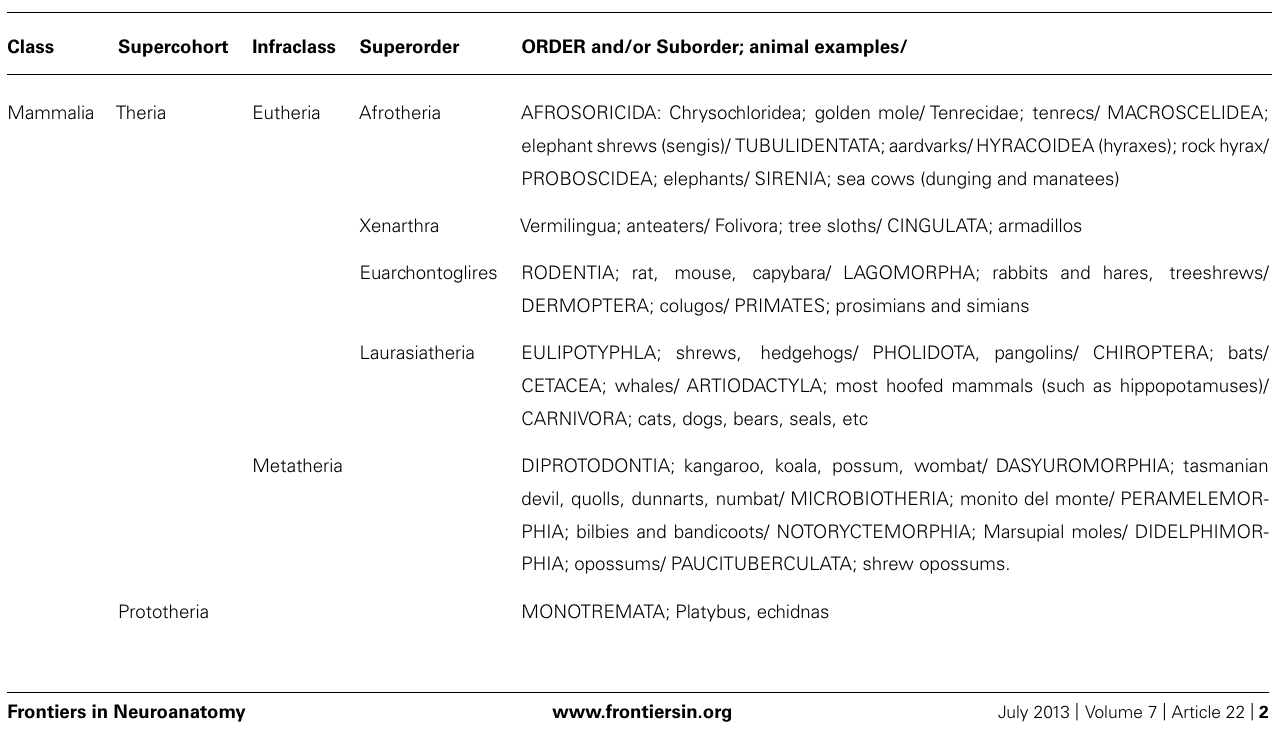
Table 1 | Primary clades of eutherian living